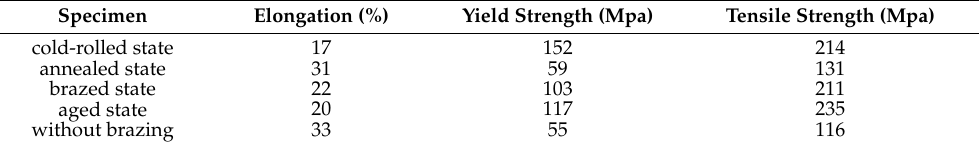
Table 2. Mechanical properties of 4343/3003/6111/3003 Al clad sheet in different conditions.